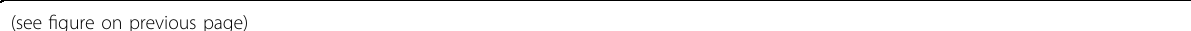
Fig. 1 Characterization of BMMC compartments in COVID-19 patients. a Schematic diagram of the experimental design. ScRNA-seq of BMMCs derived from six COVID-19 patients and three age-matched HCs from public library were analyzed. b Feature plot of transcription activities for the marker genes of major cell types. c UMAP display of a total of 39,090 BMMCs. Five major cell types are indicated. d UMAP display of the distributions of BMMCs from HCs, mild, and severe patients. e Proportions of four major cell types (excluding erythrocytes) in BMMCs for HCs, mild, and severe patients. f UMAP display of 20 clusters. g Heatmap showing the relative expression of marker genes for each cell type. Colors indicate expression, while the size of the circles represents the proportion of expressed cells. h Proportions of total T cells, total monocytes, and total granulocytes in HCs, mild, and severe patients. i Fraction of CD4 + naïve T cells and CD4 + memory T cells among total cells. j Percentage of CD14 + monocyte among total cells. k Proportion of LTF + granulocytes among total cells. l Ratio of total B cells, plasma cells, and immature B cells among total cells. m The aligned reads of the BMMC scRNA-seq dataset to the SARS-CoV-2 genome. The blue circle represents the genome of SARS-CoV-2, while red and gray circles represent positive control (previously reported BALF scRNA-seq dataset from COVID-19 patients) and BMMC samples, respectively. n Viral-Track analysis of the BMMCs scRNA-seq dataset. Only the positive control dataset (scRNA-seq data from BALF of COVID-19 patients 6 ) showed QC passed (diamond dot) signals of SARS-CoV-2. P values for pairwise comparisons were calculated, unpaired two-sided Student ’ s t- test, * P < 0.05, ** P < 0.01, *** P < 0.001, n.s., not signi fi